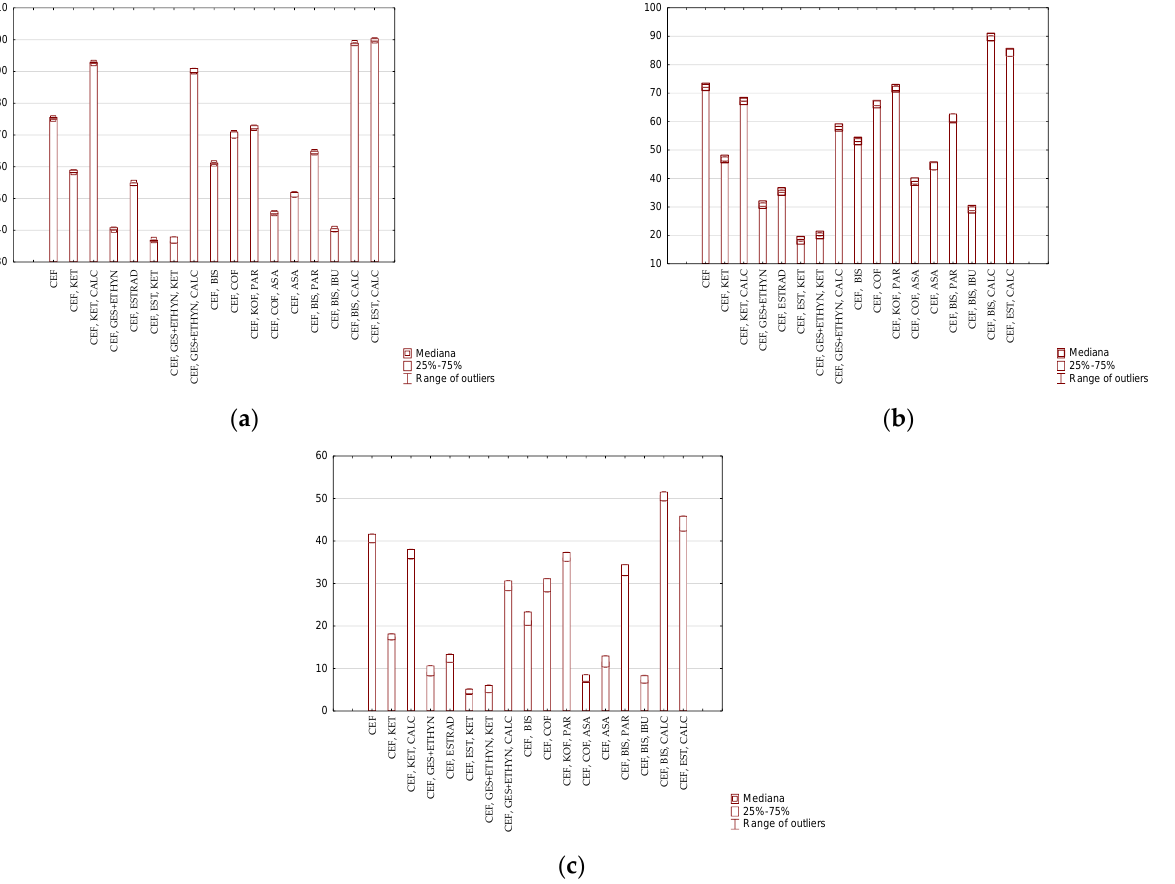
Figure 1. An example of graphical standard-deviation plots for experimental data (concentration changes in %) is presented in Table 1. ( a ) Sd for results obtained after 336 h, ( b ) 528 h, and ( c ) 1320 h. An increase in temperature by another 20 ◦ C has a destabilizing effect on the